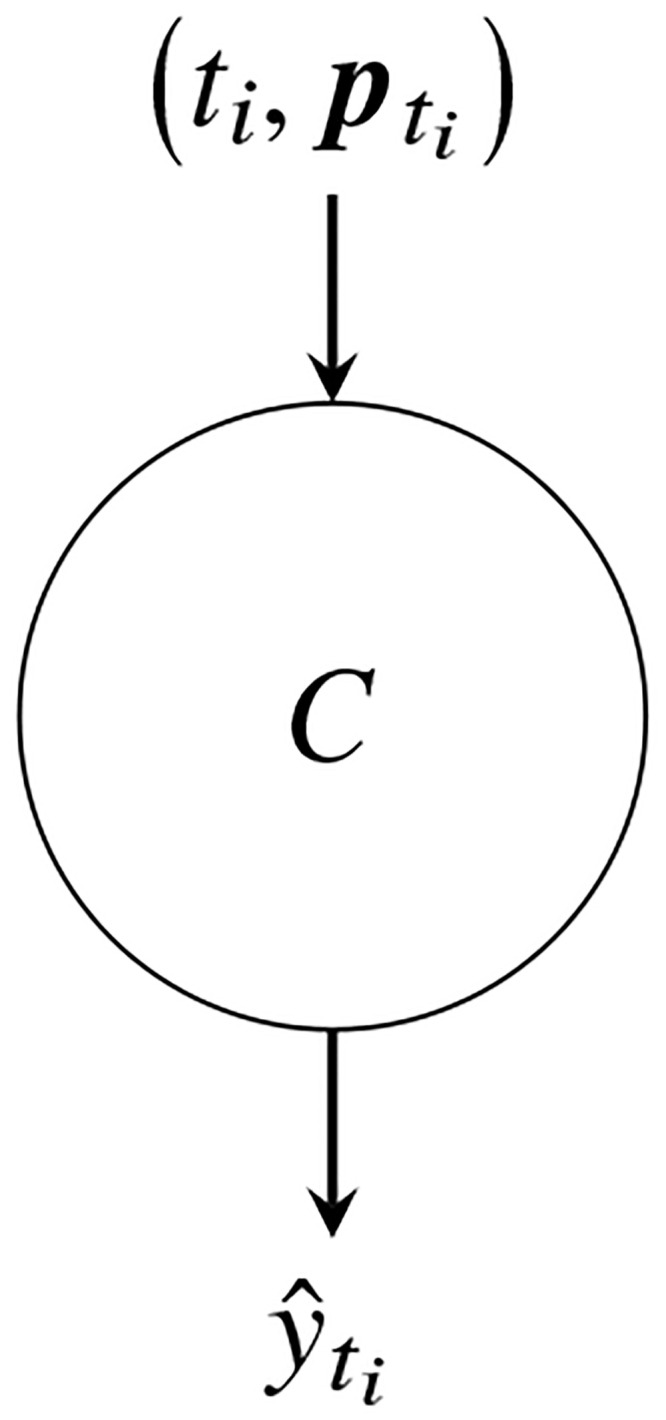
A single classifier.